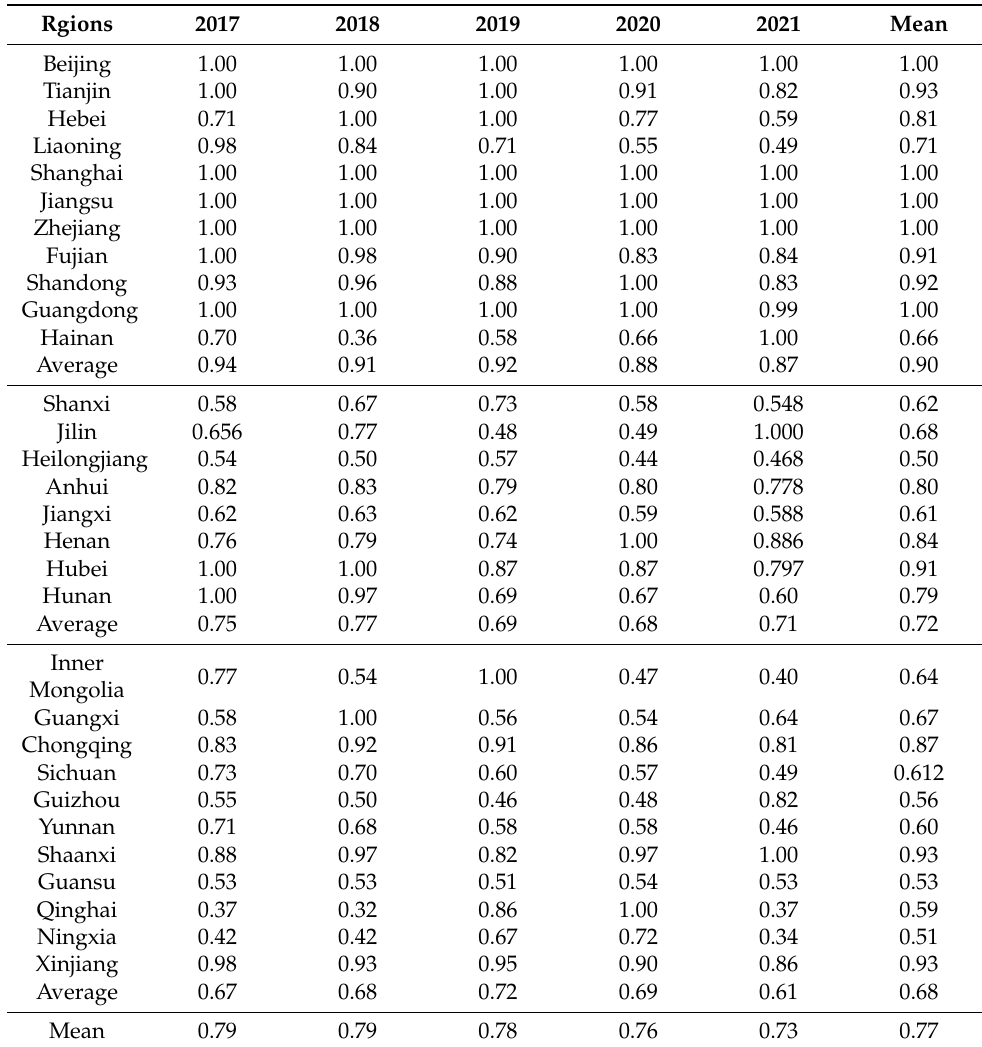
Table 3. Overall green buildings’ implementation efficiency during